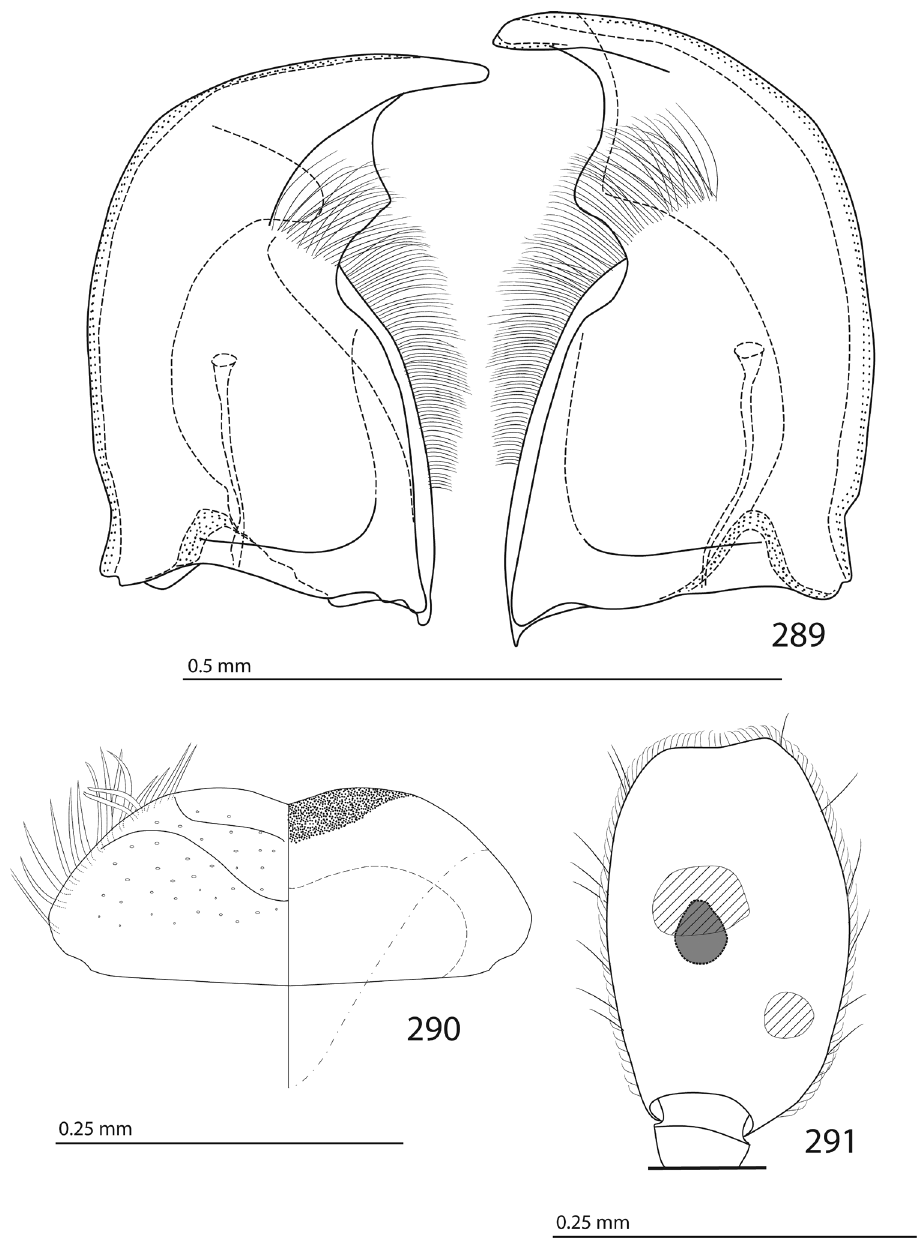
Figures 289–291. 289 Saprinodes falcifer Lewis, 1891 mandibles, dorsal view 290 labrum: left half de- picting dorsal view and right half depicting epipharynx 291 antennal club, ventral view showing sensory structures of the